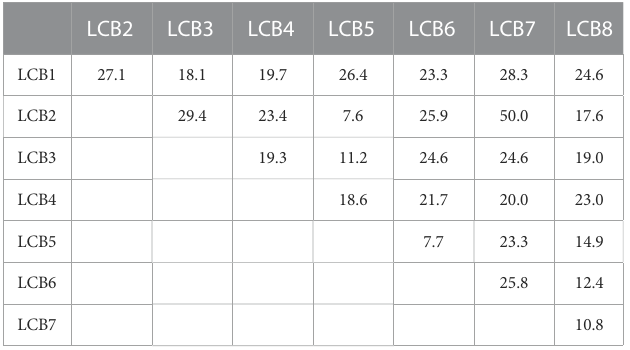
TABLE 2 Pairwise sequence identities (%) between